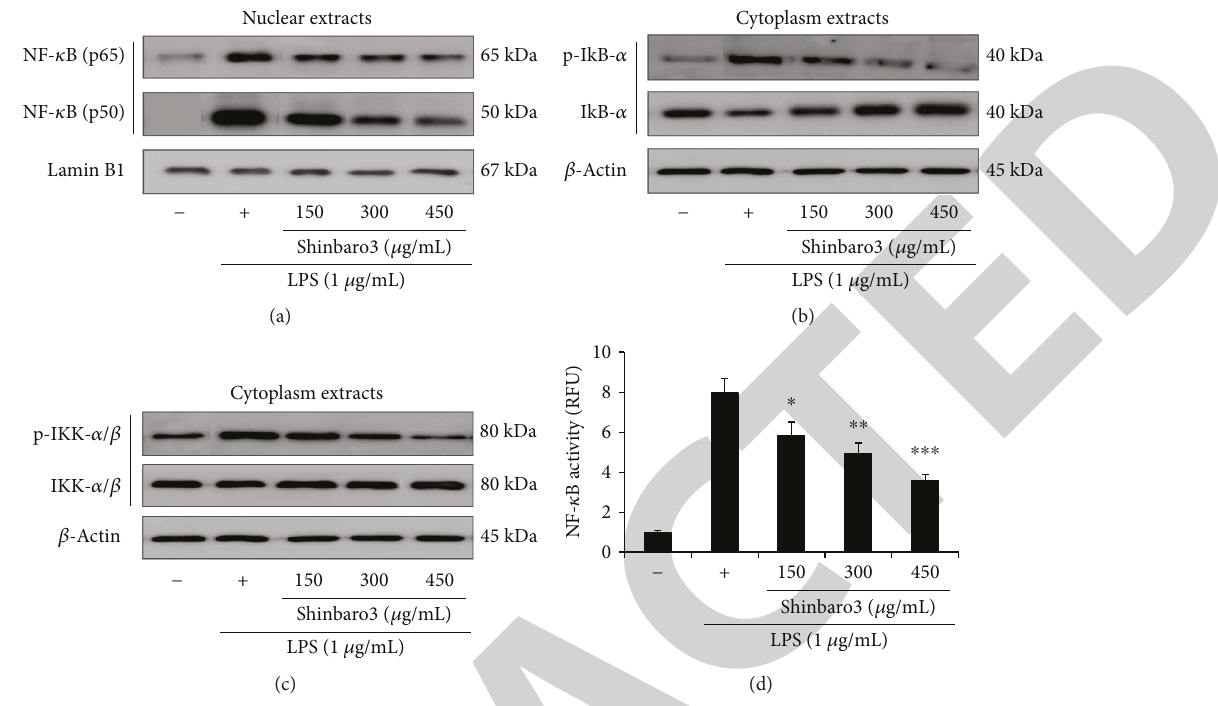
Figure 4: E ff ects of Shinbaro3 on NF- κ B activation in LPS-stimulated RAW 264.7 cells. RAW 264.7 cells were treated with LPS (1 μ g/mL) and Shinbaro3 (150, 300, and 450 μ g/mL) for 2 h to investigate protein expression or 6h for SEAP analysis. Nuclear and cytoplasm extracts were analysed via Western blotting. (a – c) The expression levels of NF- κ B (p65 and p50 subunits) (nuclear fraction), p-I κ B- α , I κ B- α , p-IKK- α , and IKK- α (cytoplasmic fraction) were measured using speci fi c antibodies. Lamin B1 (nuclear fraction) and β -actin (cytoplasmic fraction) were used as an internal control. The data are representative of three separate experiments. (d) E ff ects of Shinbaro3 on NF- κ B transcriptional activity were assessed though a reporter gene assay. Relative fl uorescence units (RFU) were measured by using a fl uorometer for secreted alkaline phosphatase activity (SEAP). The data are expressed as the mean ± SD ( n = 3 ). ∗ p < 0 05 , ∗∗ p < 0 01 , and ∗∗∗ p < 0 001 versus LPS treatment alone.